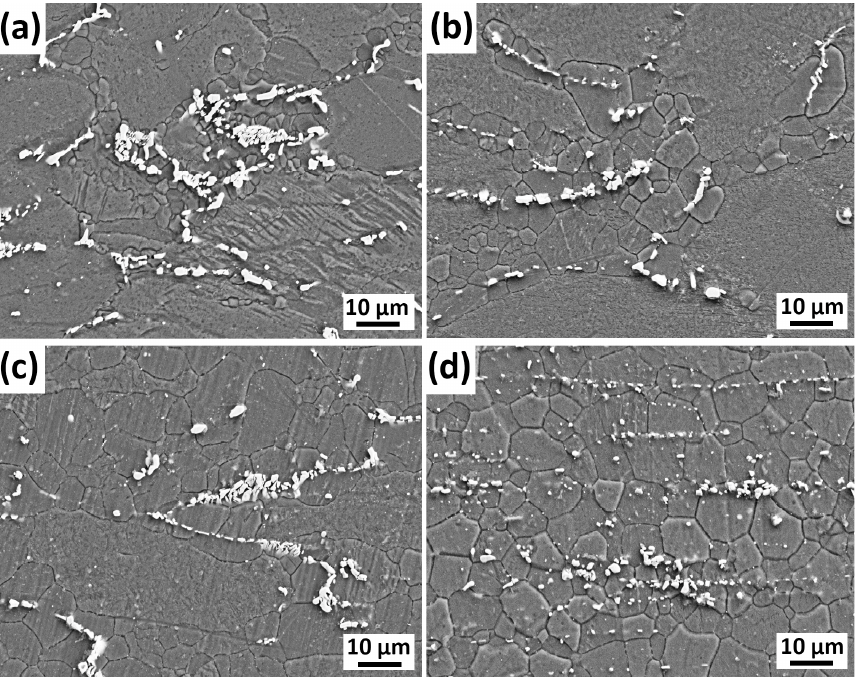
Figure 6. SEM micrographs of the alloys extruded at ( a ) 250 °C, ( b ) 300 °C, ( c ) 350 °C, and ( d ) 400 °C.